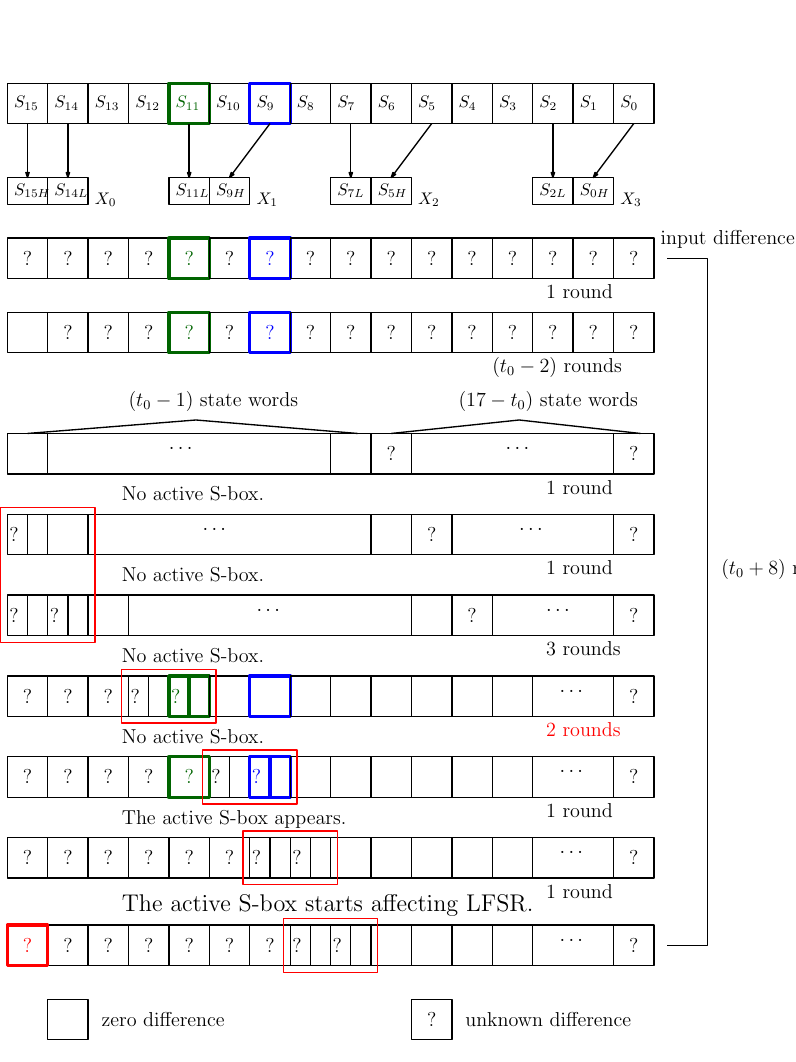
Figure 2: The big picture of our